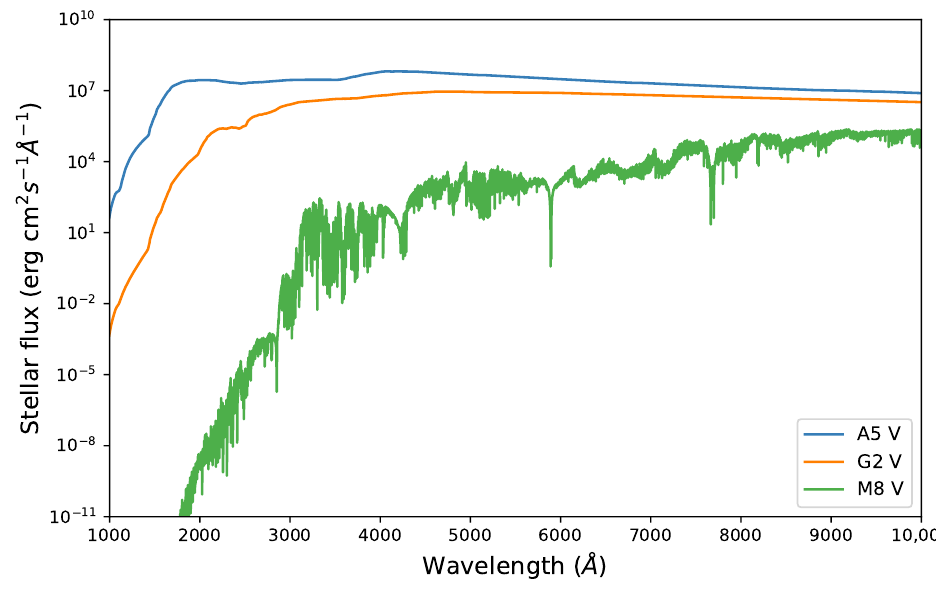
Figure A2. Spectral energy distribution from the far ultraviolet to the near infrared of the A5V-, G2V-, and M8V-type stars used in the overlap.